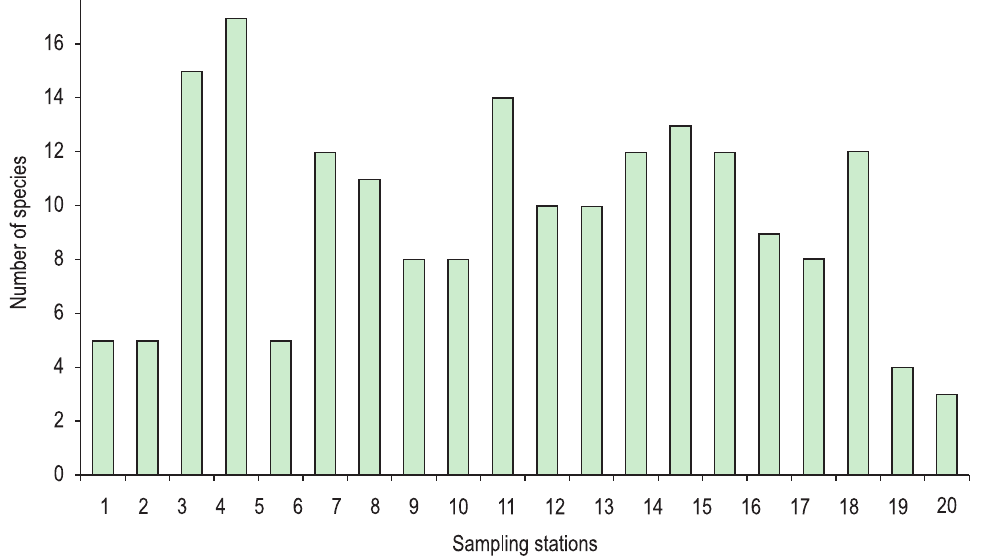
Figure 5. Richness of the species recorded in 20 sampling stations of the basin of the Apodi/Mossoró River, RN, Northeast